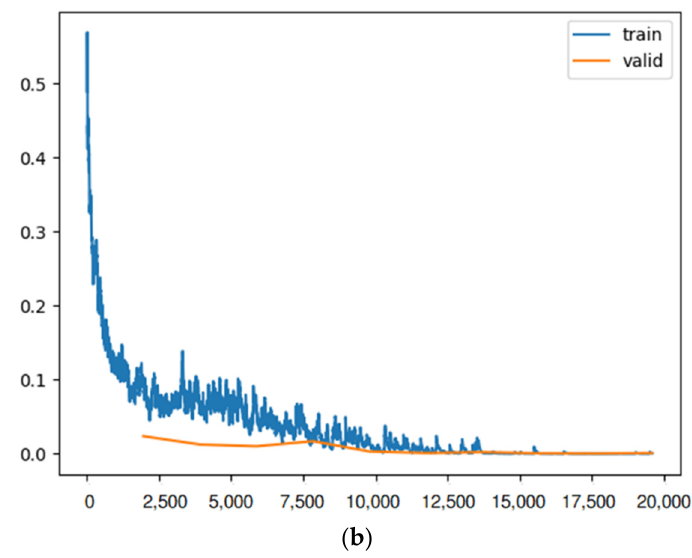
Figure 12. ( a ) Confusion matrix and ( b ) loss rate during training with ResNet 50.